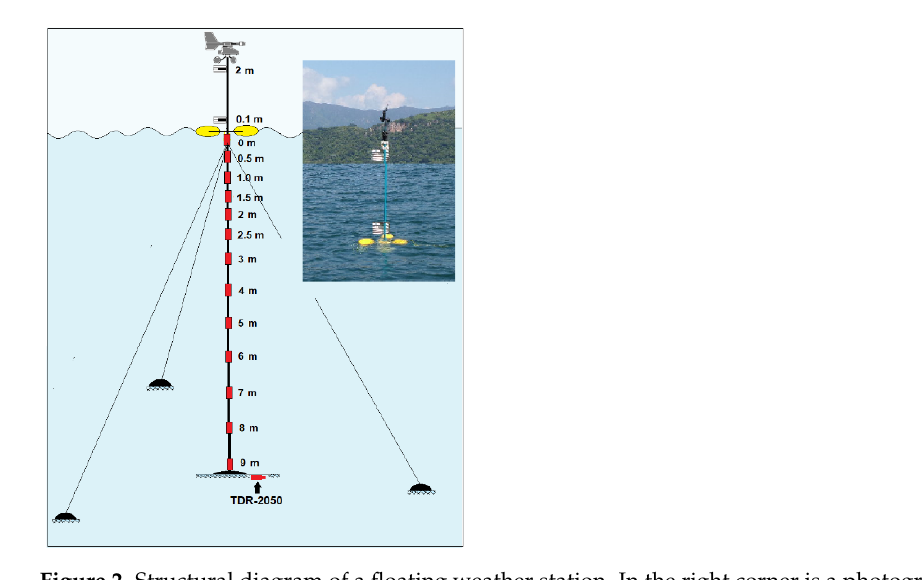
Figure 2. Structural diagram of a floating weather station. In the right corner is a photograph of the part of the station above the water